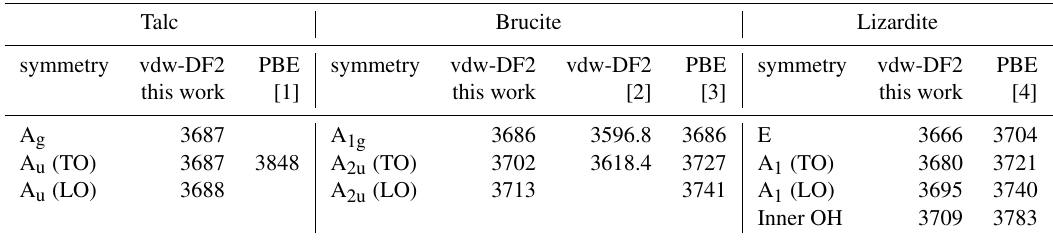
Table 5. Zone-center theoretical frequencies (cm − 1 ) of OH stretching modes in talc, brucite and lizardite. Theoretical vibrational modes are provided in the Supplement.